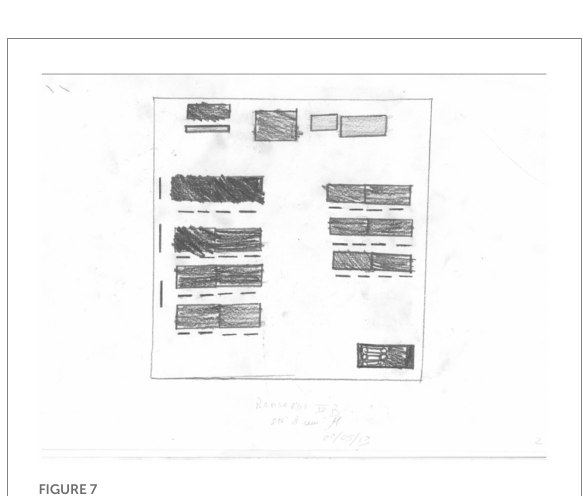
FIGURE 7 Classroom drawing: an empty class example, integration 0. Male, 8 years